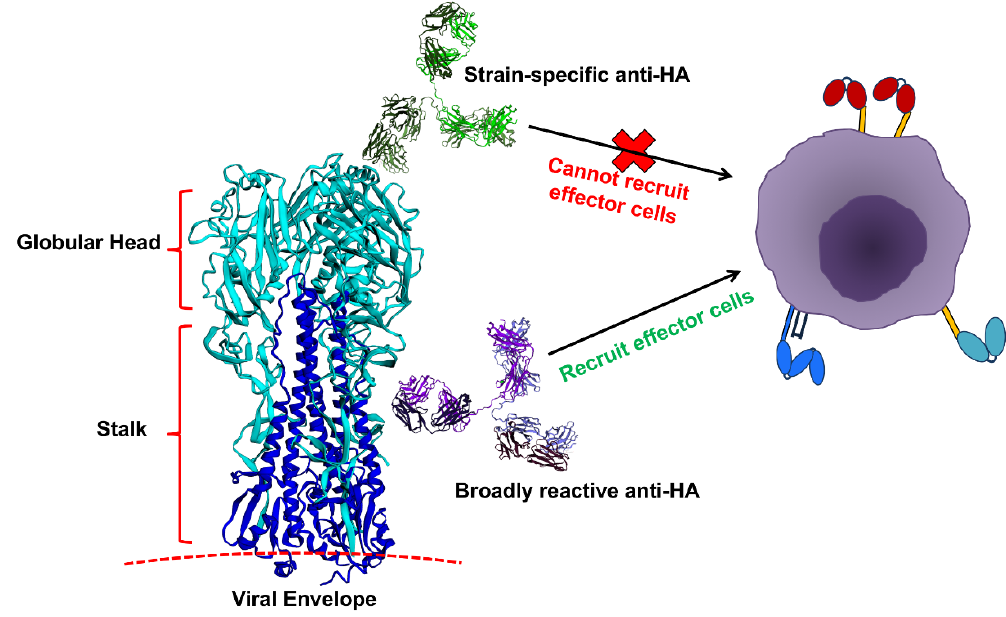
Figure 2. Anti-hemagglutinin (HA) specificity can dictate the capacity of IgGs to recruit effector cells. Anti-globular head antibodies that act by blocking HA-sialic acid interactions, most of which are strain-specific, do not engage FcγRs. Anti-HA IgGs that do not prevent the HA-sialic acid interactions, such as anti-stalk IgGs, can engage FcγRs, possibly due to stabilization of Fc-FcγR interactions arising from avidity interactions between HA on the infected cell with sialic acids on the effector cell. Image components not to scale.